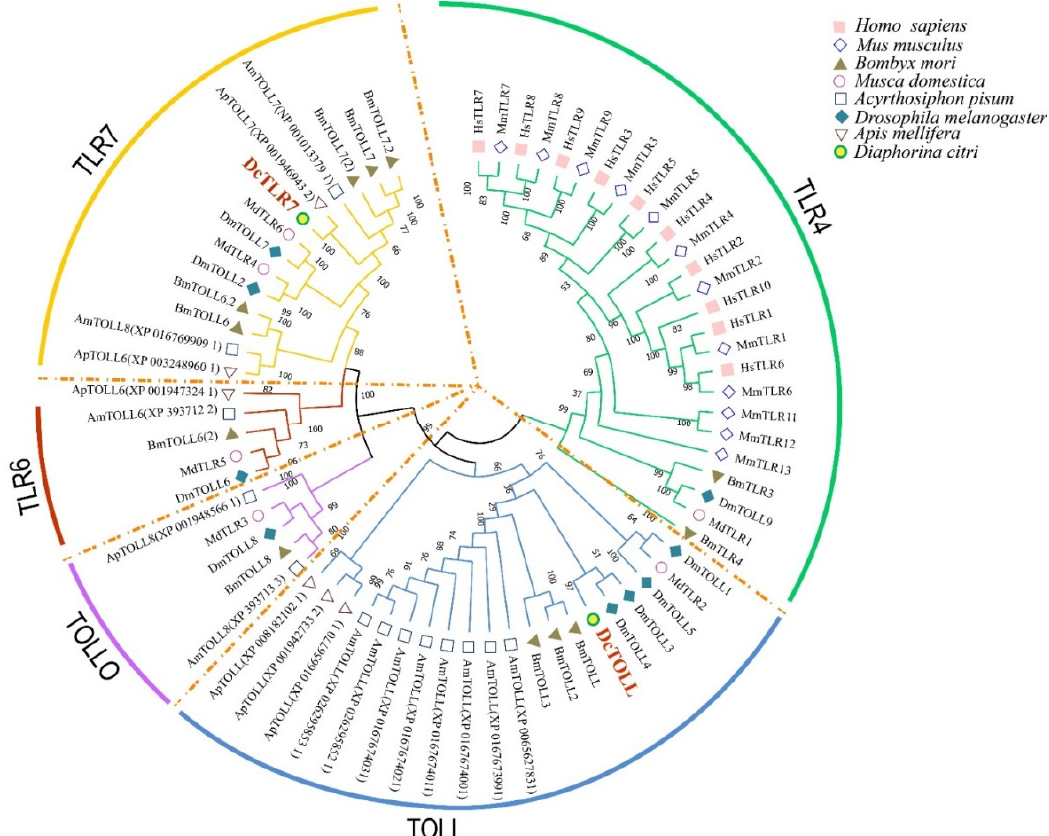
Figure 2. Phylogenetic tree with full-length amino acid sequences of Diaphorina citri , Apis melifera , Drosophila melanogaster , Acyrthosiphon pisum , Musca domestica , Bombyx mori , Mus musculus and Homo sapiens TLR proteins. The maximum likelihood method using MEGA X software with 1000 bootstrap replicates was used to construct the phylogenetic tree. The tree could be divided into 5 major clusters, and each cluster was named according to the dominant proteins and marked with different colors.